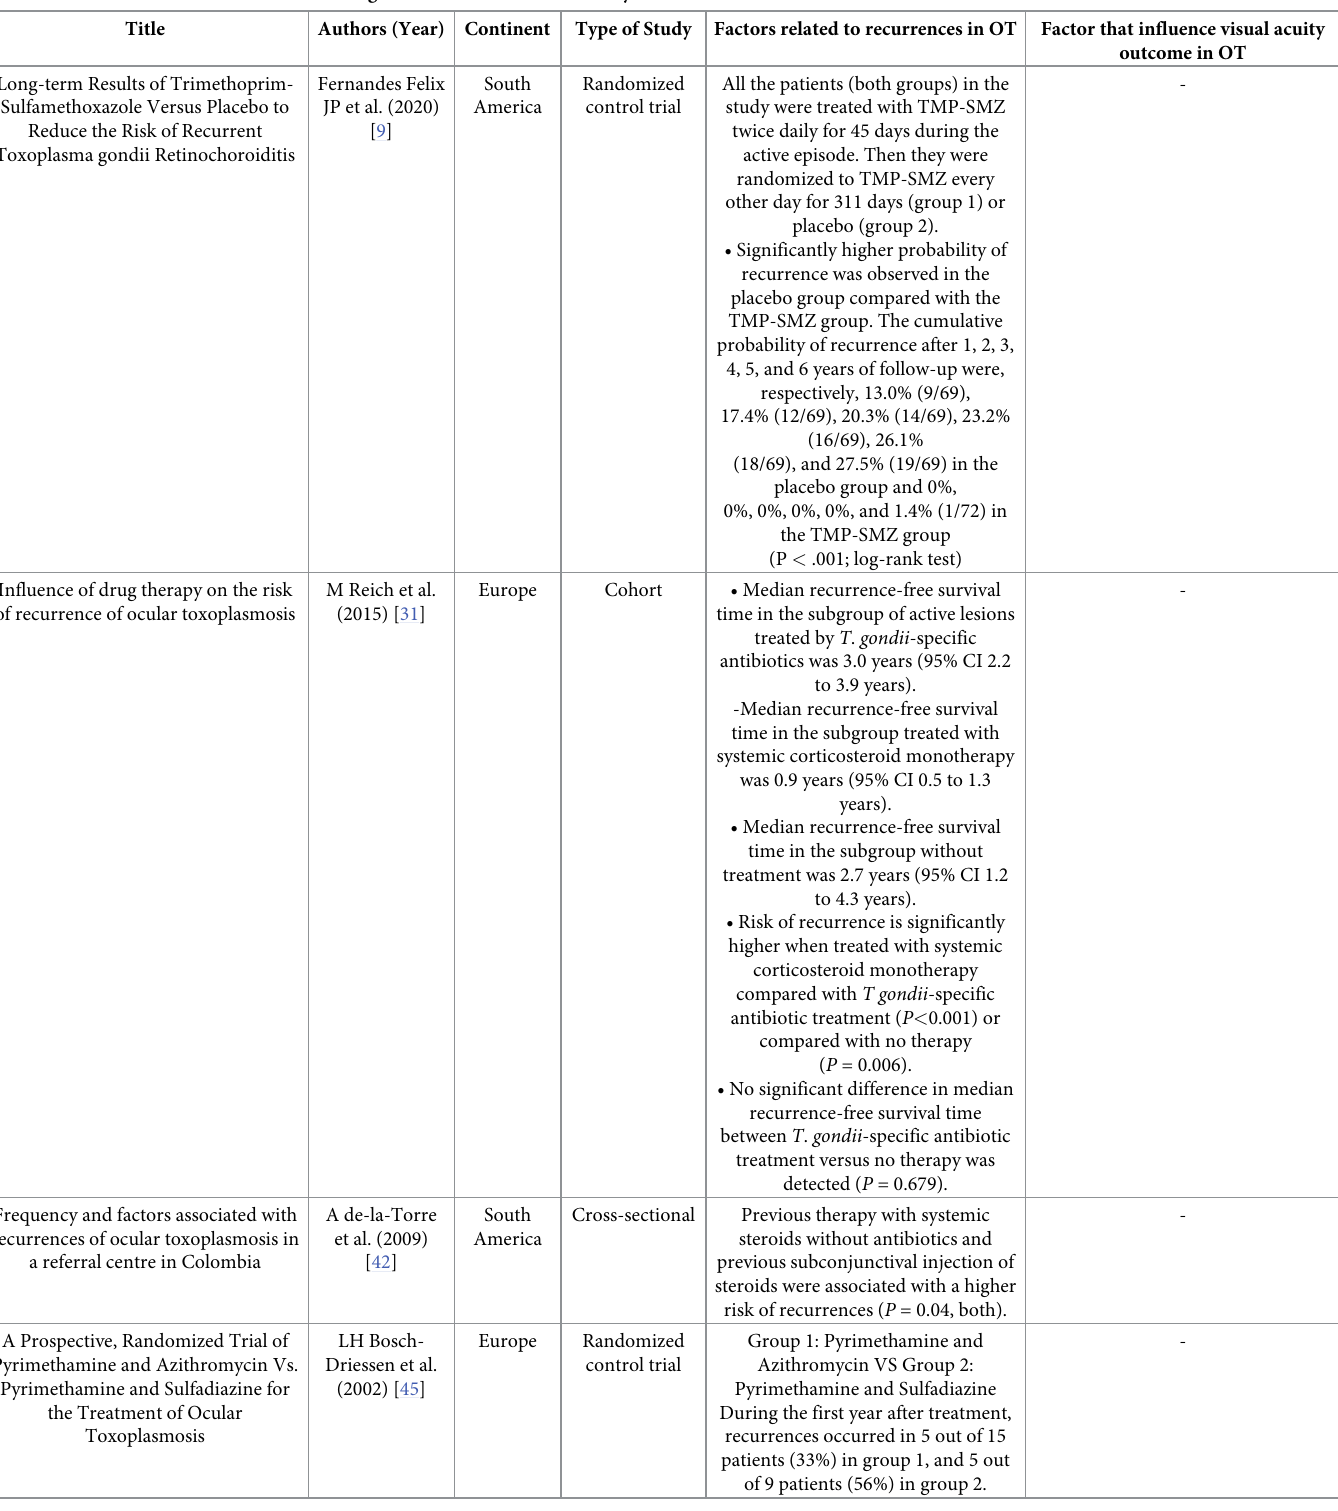
Table 3. Treatment-related factors influencing reactivations and visual acuity outcomes in